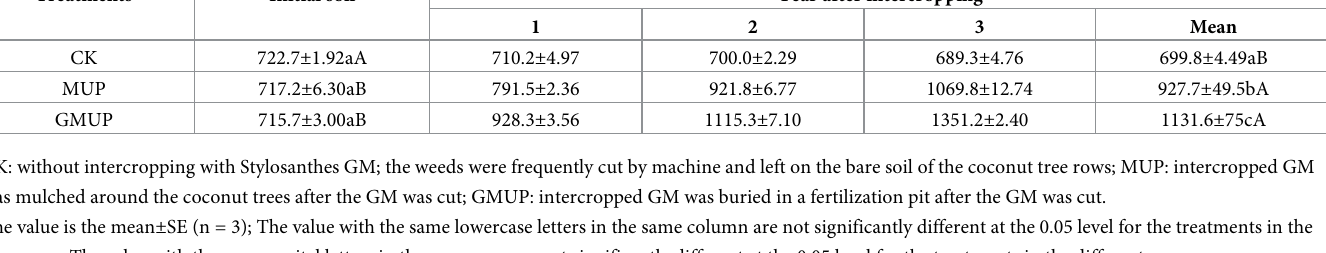
Table 1. Total nitrogen content of different treatments in the initial soil and the soil after different intercropping years (mg � kg -1 ). Treatments Initial